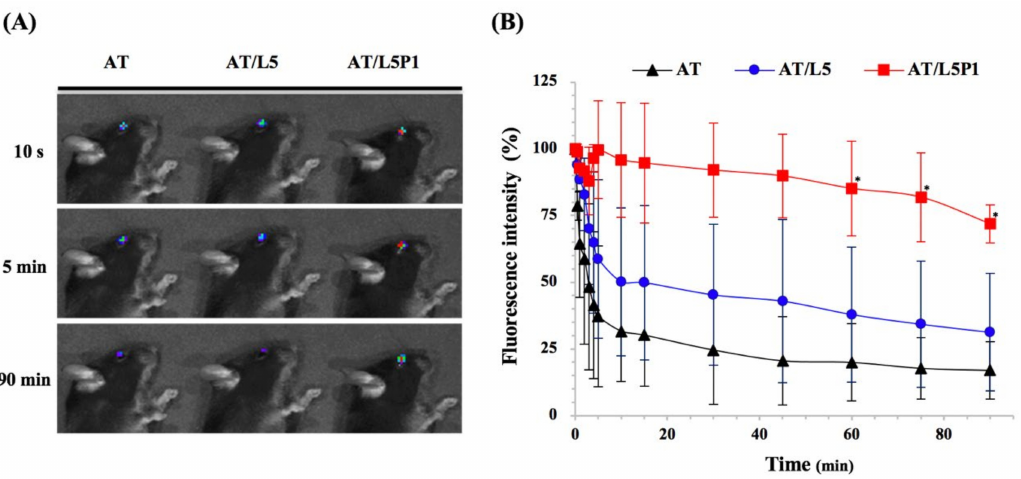
Figure 4. Retention test on the ocular surface. ( A ) Accumulation of fluorescent on mouse eyes after dosing with different formulations. ( B ) Quantitation of fluorescence intensity on the ocular surface traced by IVIS at different time intervals. Data are expressed as the mean ± standard deviation (SD); n = 3. (* p < 0.05 compared with the AT